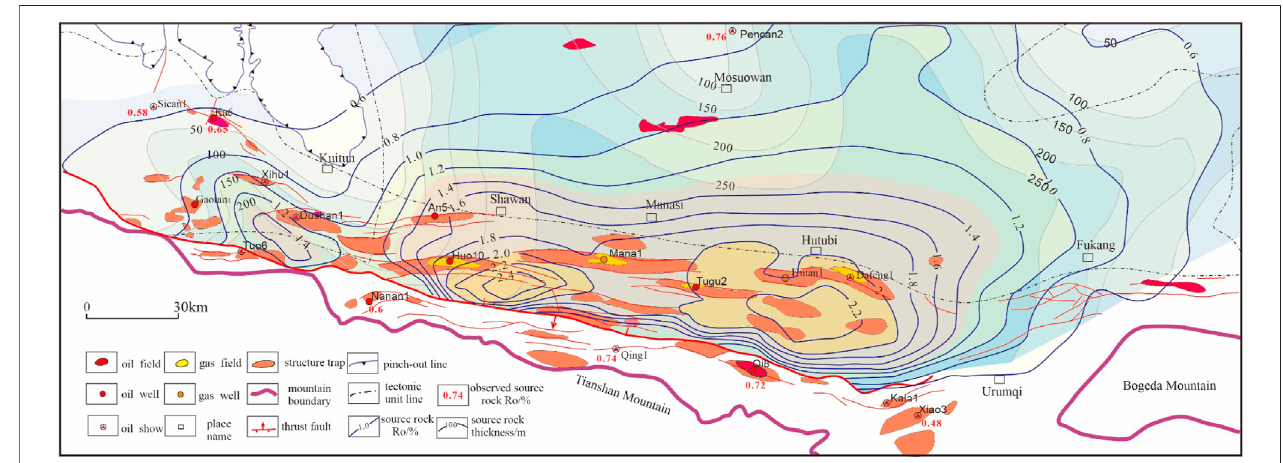
FIGURE11| MapshowingtheJurassicsourcerockmaturity anddistribution ofoilandgasintheSouthJunggarforelandbasin.ThemeasuredRoofsomewellsis shown in the map.